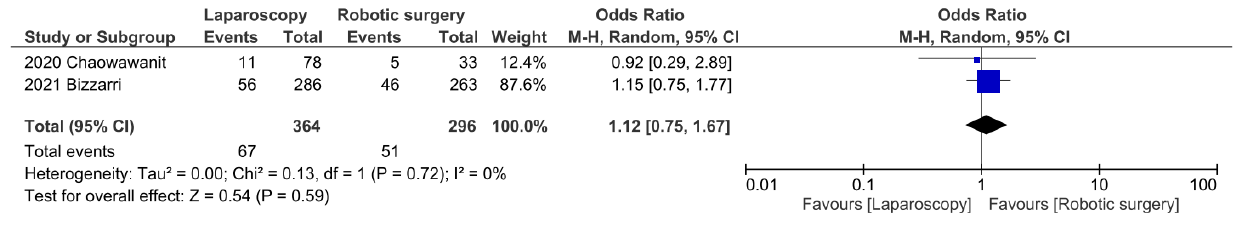
Figure 4. Forest plot of individual and pooled odds ratios, with 95% confidence interval (CI), for bilateral detection, comparing laparoscopy and robotic surgery for SLN biopsy in EC women.